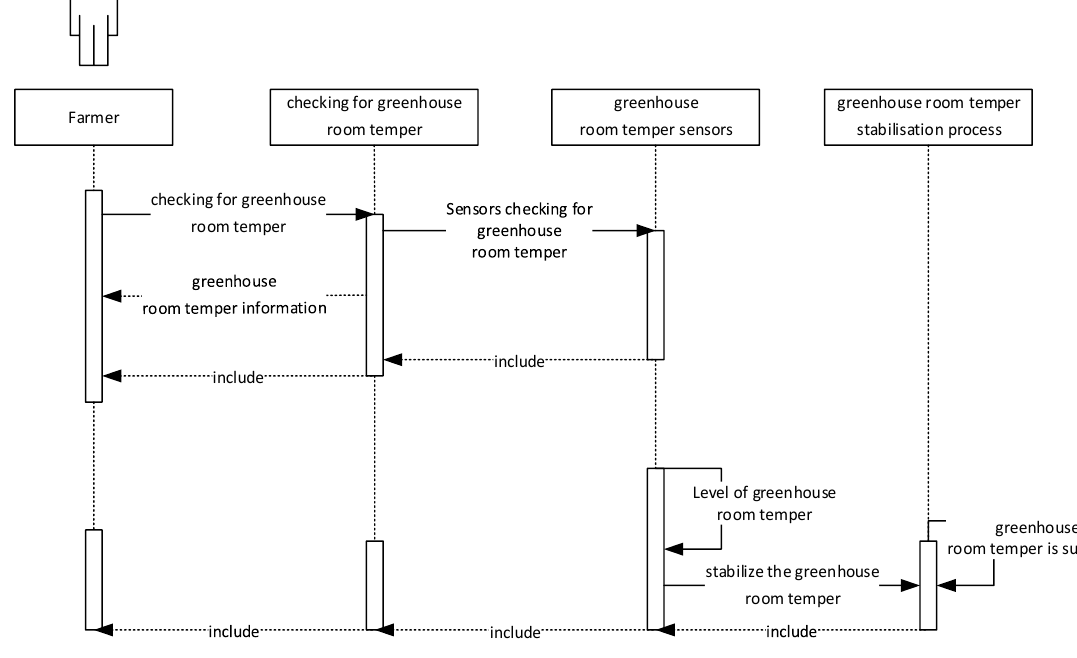
Figure 4. Sequence Diagram of onion temperature